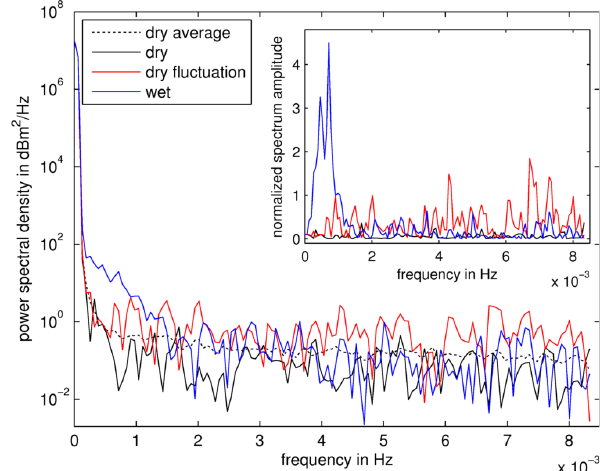
Fig. 3. Typical spectra for 256min snippet (with a Hamming win- dow) from a RSL time series for different atmospheric conditions. The inset shows the spectra normalised with the average dry spec- trum by division. Deviation from the mean dry spectrum is largest for the low frequency part of the wet -spectrum. Note that for the dry fluctuation -spectrum the observable deviation is highest in the high frequency